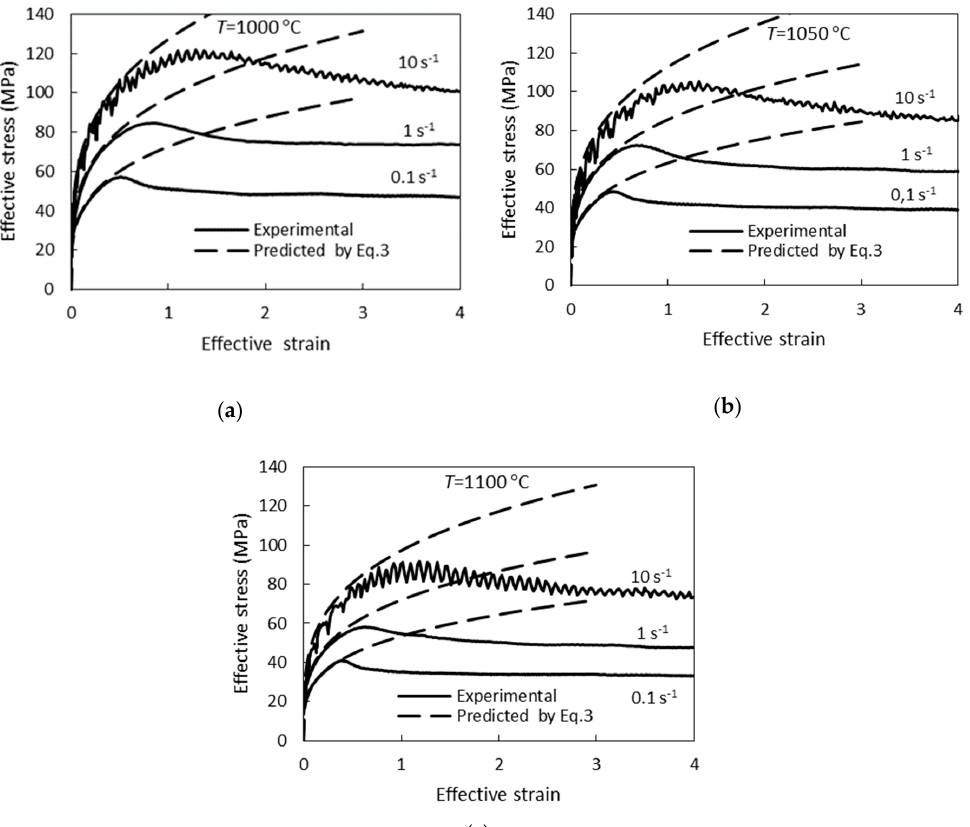
Figure 3. Experimental hot torsion flow curve determined at ( a ) 1000 ◦ C, ( b ) 1050 ◦ C, and ( c ) 1100 ◦ C and curve predicted by Equation (3).